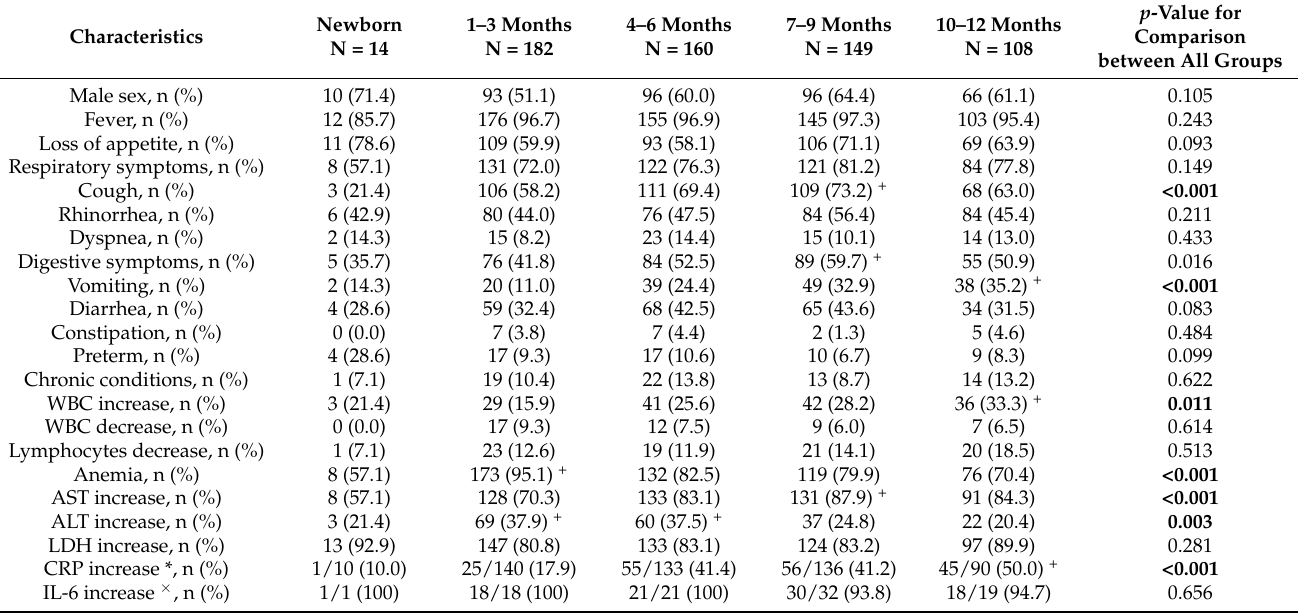
Table 3. Data analysis according to age group.